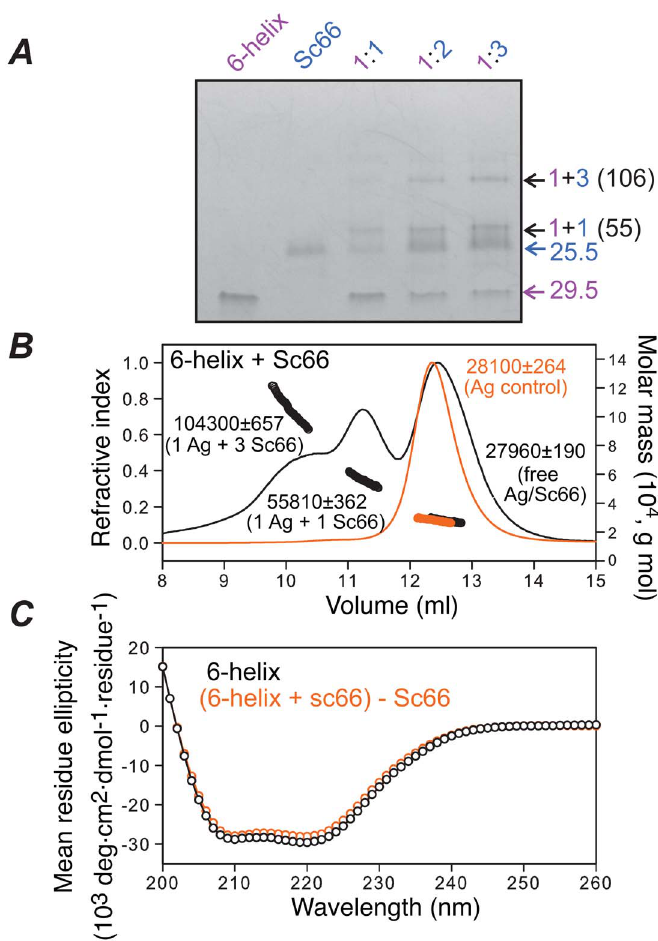
Figure 5. Native-PAGE, SEC-MALS and CD analysis of 6-helix-antibody complexes. ( A ) Native-PAGE in the presence of increasing molar ratios of Sc66 to 6-helix. 6-helix to Sc66 ratios are shown above the respective lanes and the observed stoichiometry of the complexes (purple, 6-helix; blue, Sc66) and expected molecular weights (kDa) are indicated. ( B ) SEC-MALS for 6-helix alone (orange) and a 1:1 mixture of 6-helix with Sc66 (black). Average compositions and masses are indicated next to the peaks. ( C ) CD spectra of 6-helix alone (black) and a 1:2 mixture of (6 helix + Sc66) minus Sc66 alone (orange). The CD data indicate that there is no change in helicity of 6-helix upon complexation with Sc66.